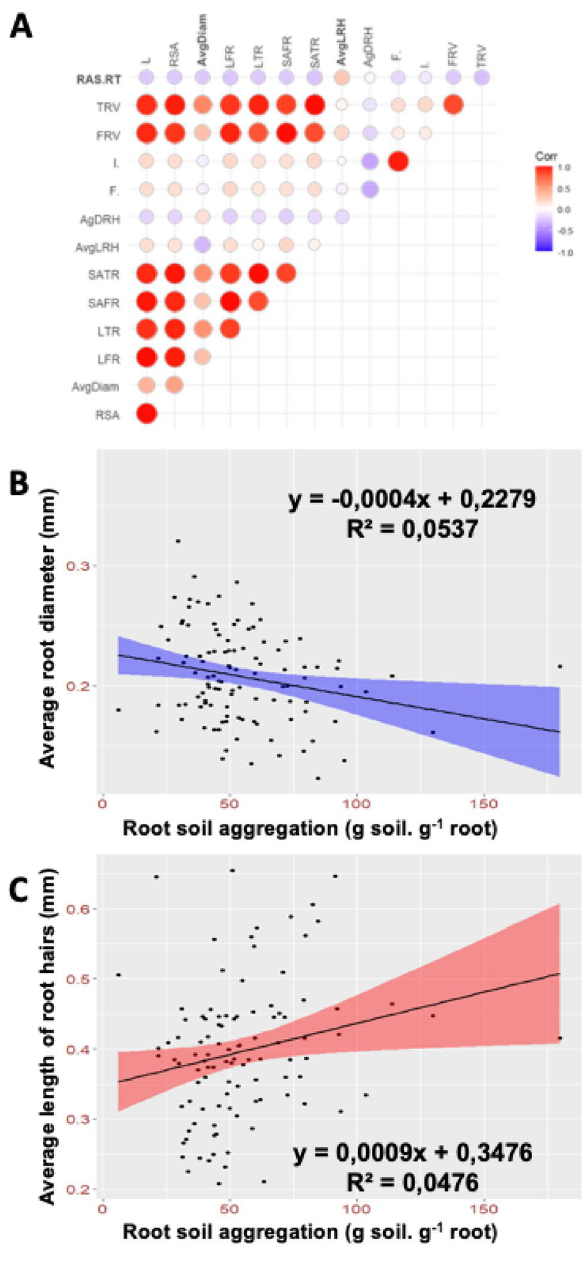
Figure 1. Relation between root soil aggregation, root architecture, root hair development and arbuscular mycorrhizal symbioses. (A ) Pearson correlation between traits using adjusted lsmeans across two experiments conducted in different years. ( B ) Linear regression between root diameter and root soil aggregation. Points represent the mean value of the traits for inbred lines across the two experiments. ( C ) Linear regression between root hair length and root soil aggregation. Points represent the mean value of the traits for inbred lines across the two